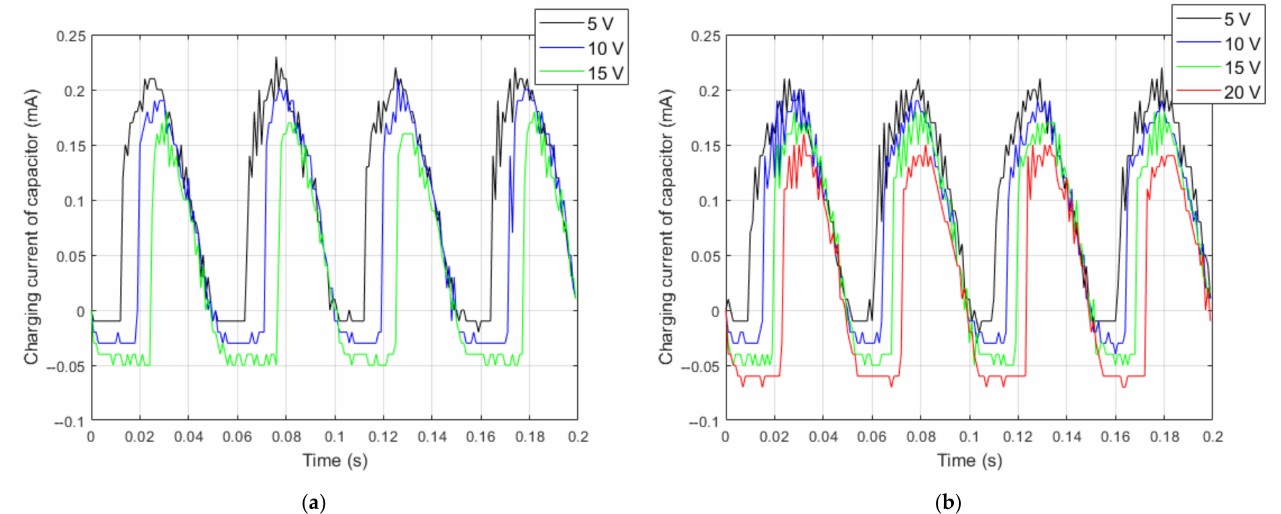
Figure 15. Current courses: ( a ) for unimorph; ( b ) for bimorph with series